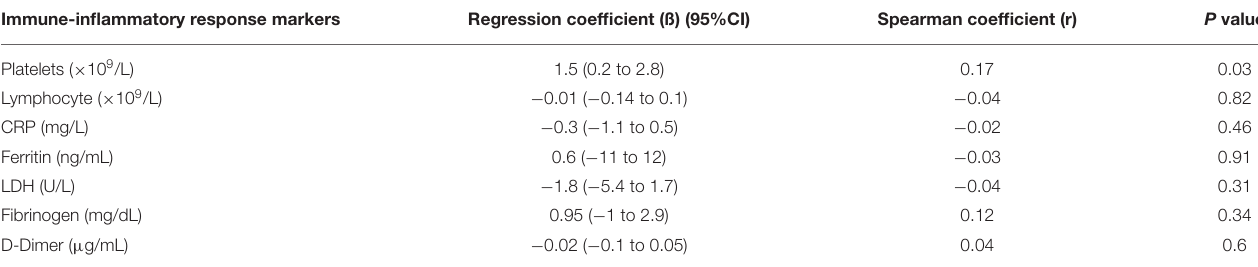
TABLE 5 | Linear regression model investigating the correlation between serum 25(OH)D levels and immune -inflammatory response biochemical markers.